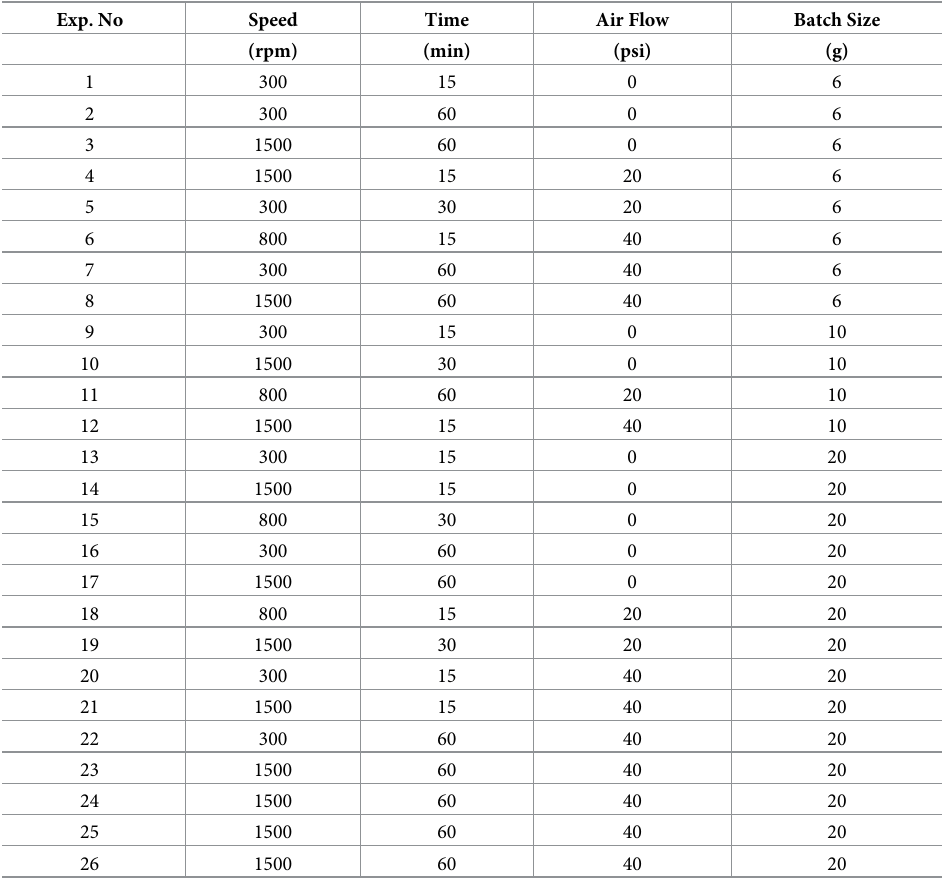
Table 1. The D-optimal design worksheet with CPPs and the total number of runs. Exp.